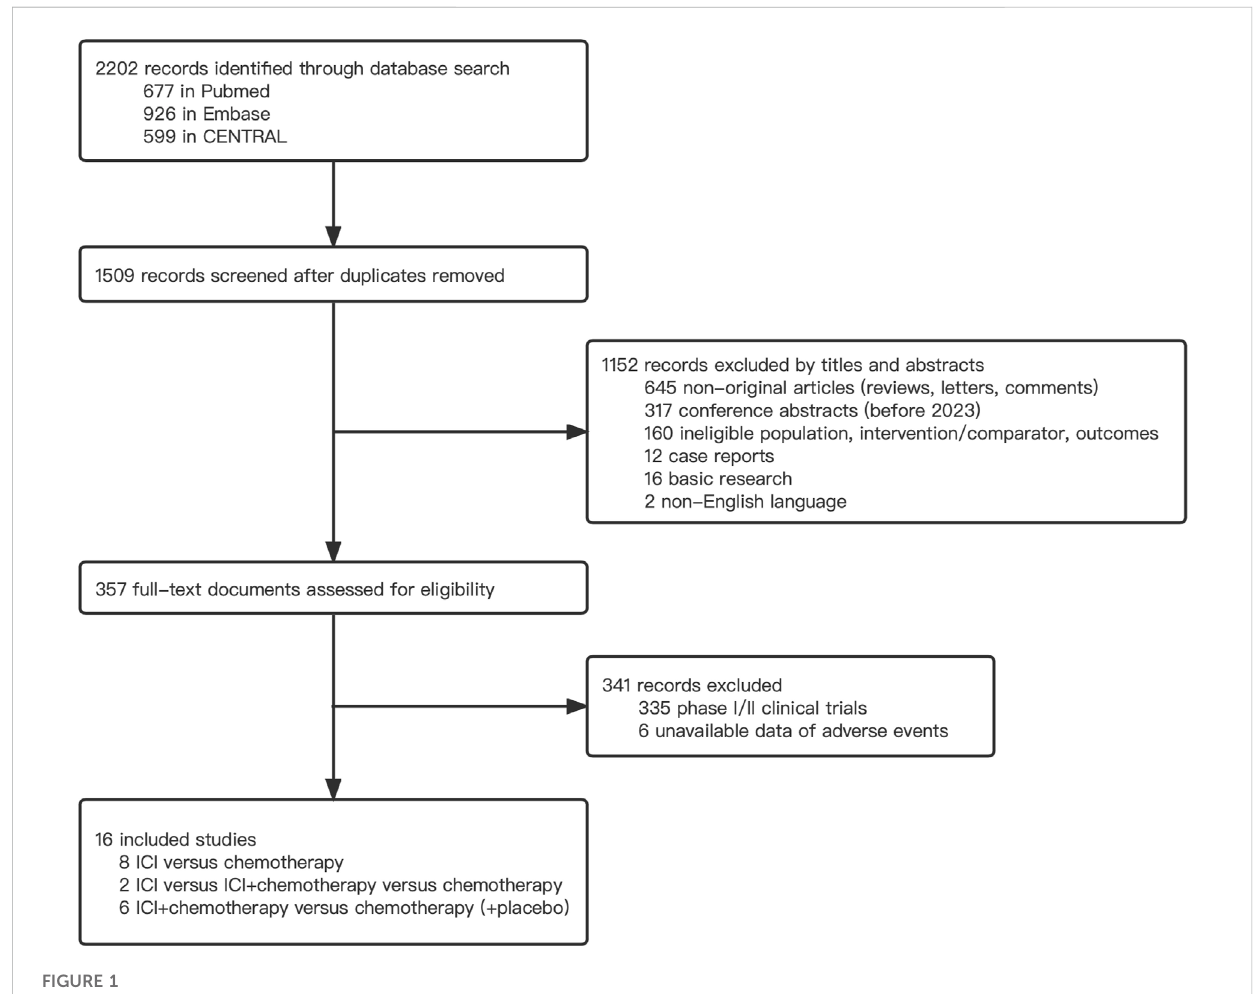
FIGURE 1 Flow chart of the study